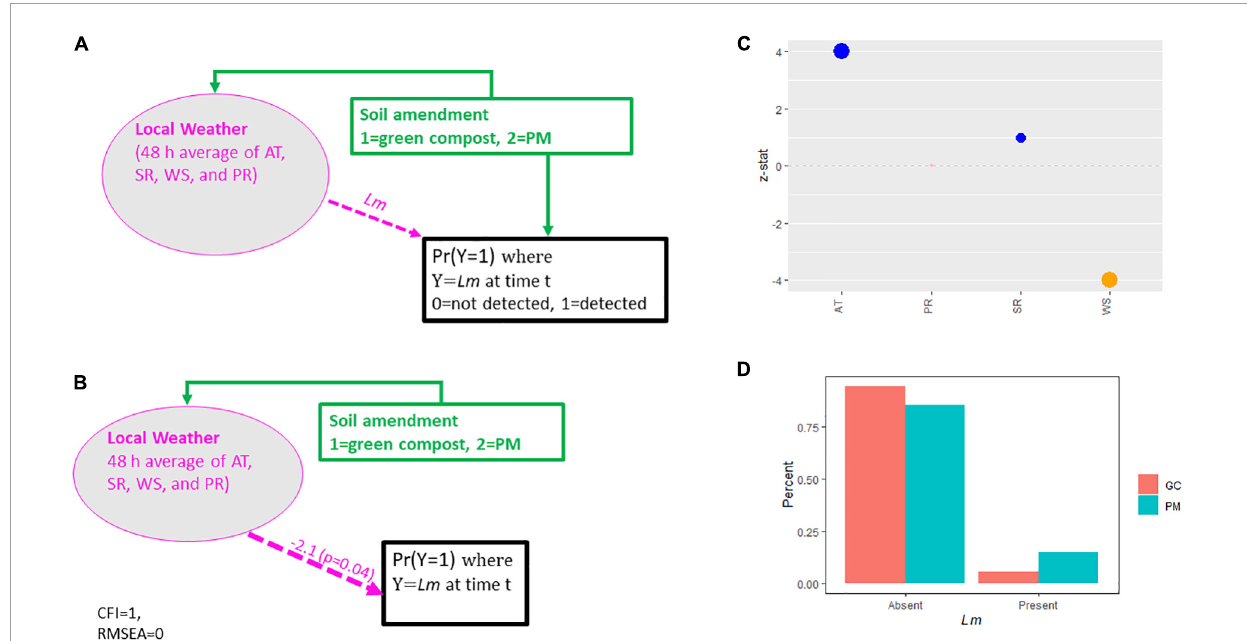
FIGURE2 (A) Conceptual model for Lm prevalence in GA soil. (B) Final estimated model for Lm prevalence in GA soil. (C) Weather effect sizes. GC, green compost. (D) Lm prevalence in GA soil by soil amendment type. PM, poultry manure; AT, air temperature; SR, solar radiation; PR, precipitation; WS, wind speed; CFI, comparative fit index; RMSEA, root mean square error of